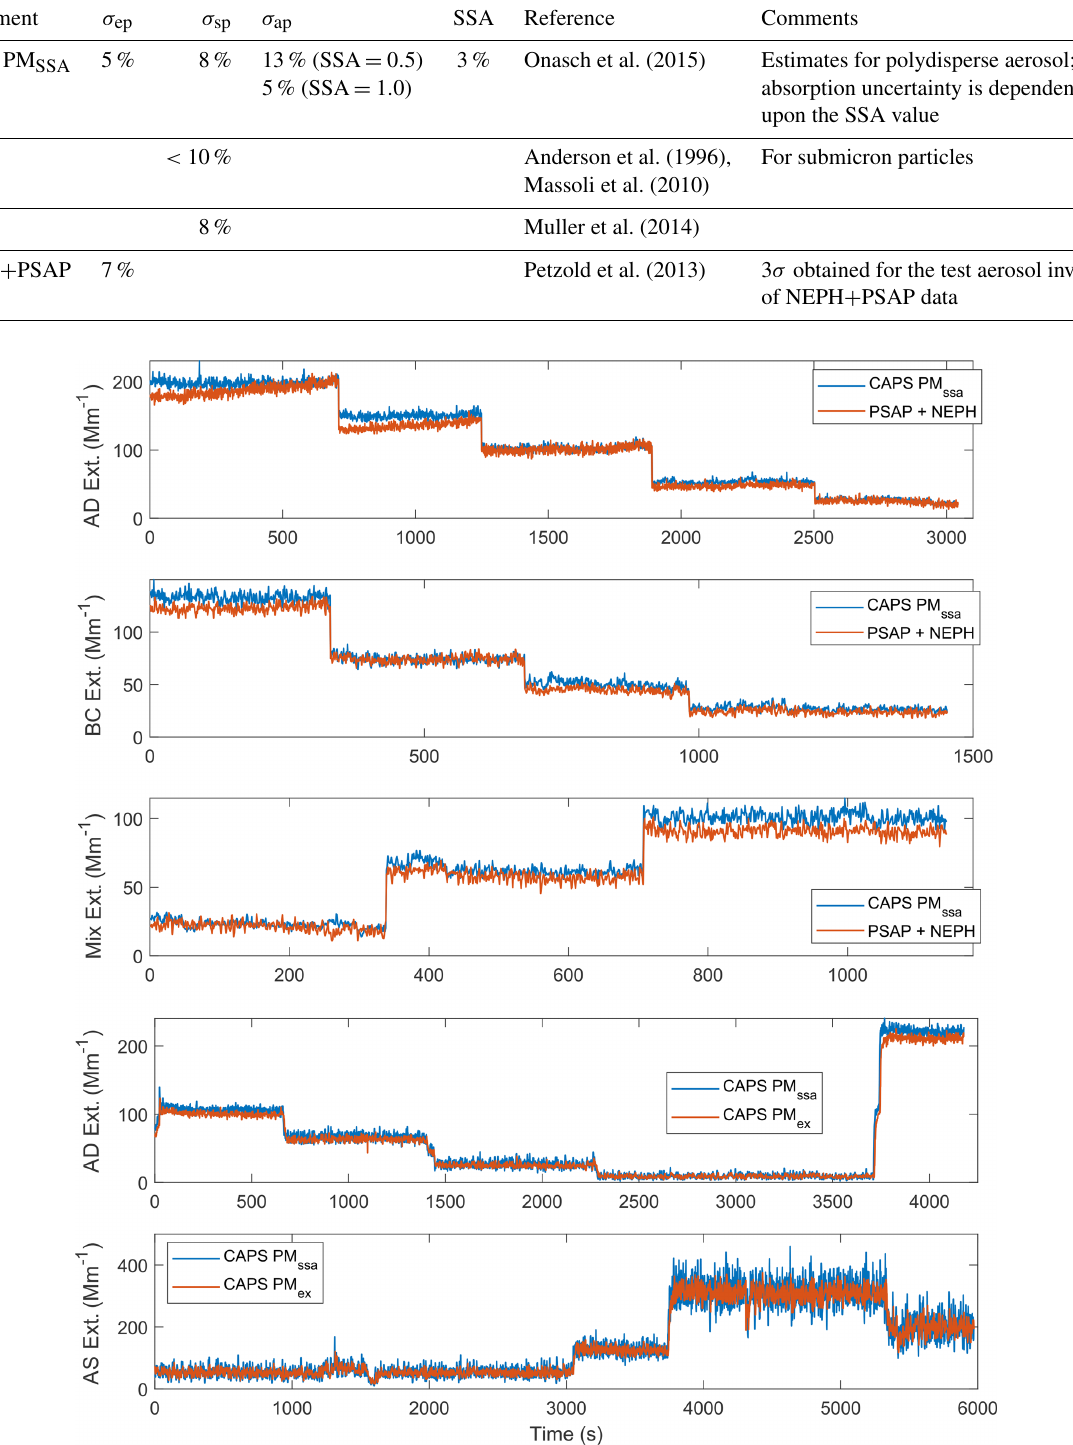
Figure 4. Time series (1Hz) of the simultaneously measured extinction coefficients by the different instruments. Instruments used: CAPS PM ex , CAPS PM SSA and the sum of absorption and scattering coefficients measured by PSAP and NEPH as noted in the legend for the individual subplots. The test aerosols used are noted in the caption of the y axis of the individual